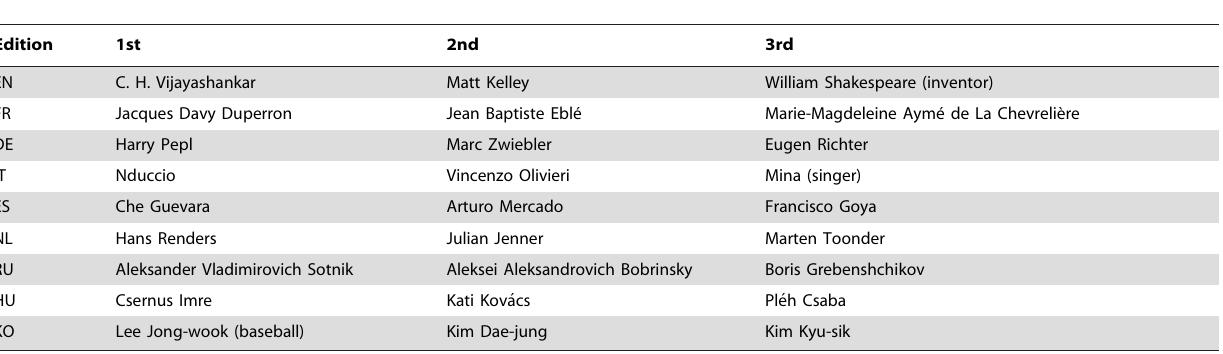
Table 5. List of local heroes by CheiRank for each Wikipedia edition.